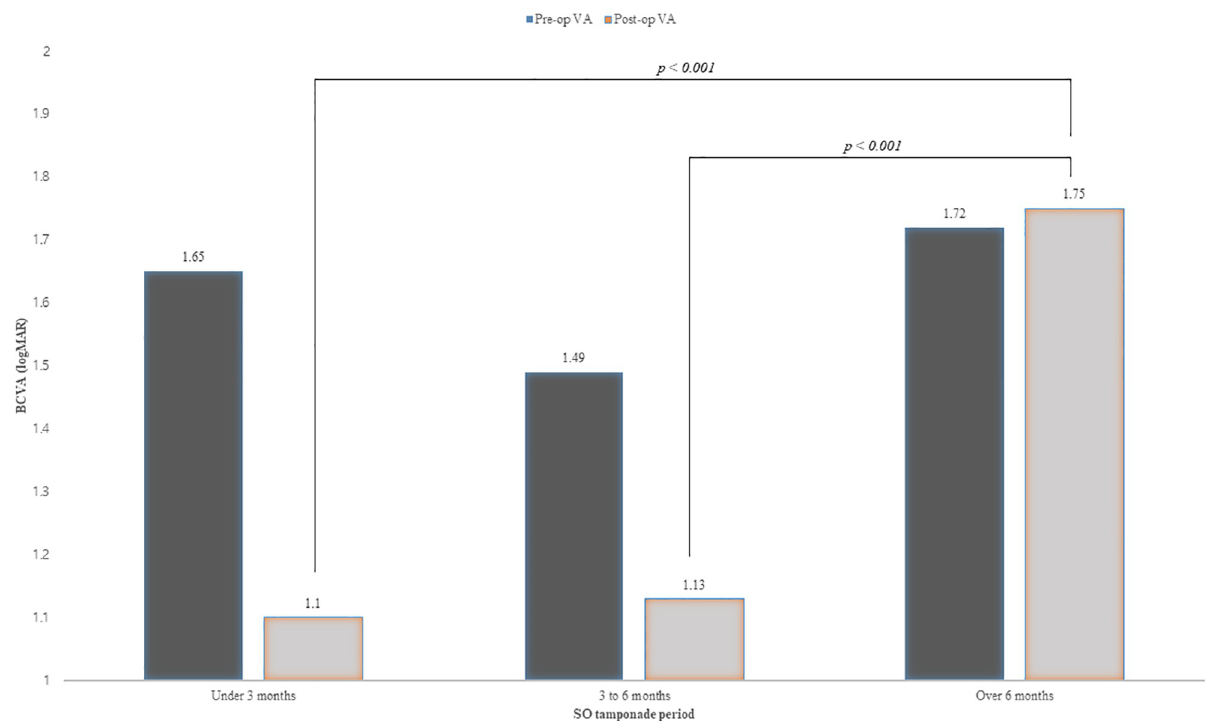
Fig 1. Comparison of BCVA(logMAR) before and after SO removal according to SO tamponade period. Prior to SO removal, there was no significant difference in BCVA between the three groups, but after removal, there was a significant difference in visual acuity between 3–6 months tamponade group and over 6 months tamponade group, and under 3 months tamponade group and over 6 months tamponade group.